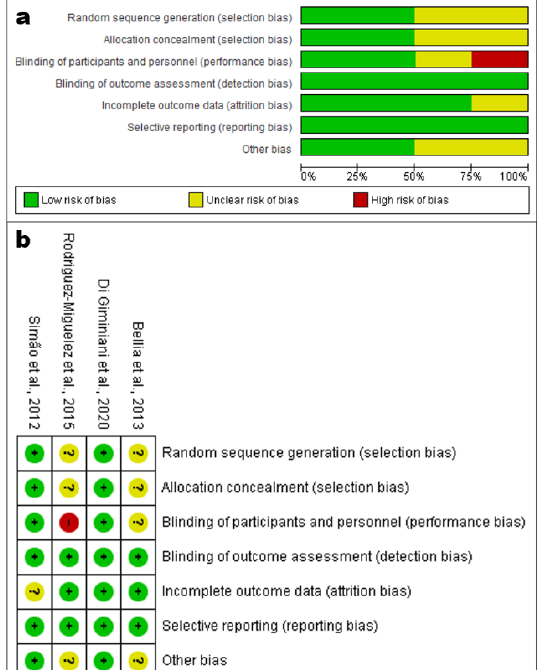
Figure 2. ( a ) Risk-of-bias graph and ( b ) summary indicating the risk of bias of each domain in each study. Green indicates low risk of bias, yellow indicates unclear risk of bias, and red indi- cates high risk of bias of the studies: Bellia et al., 2013 [40], Rodriguez-Miguelez et al., 2015